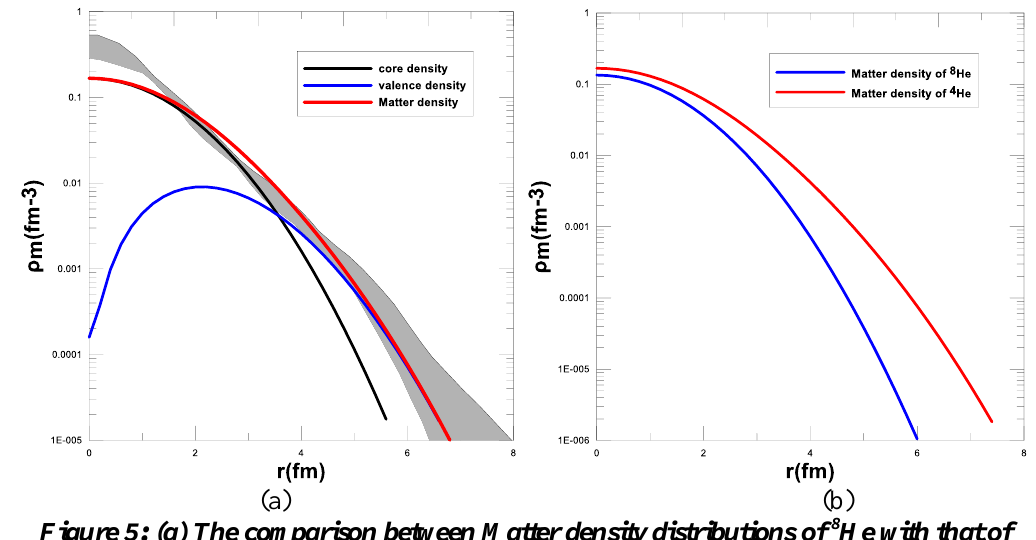
Figure 5: (a) The comparison between Matter density distributions of 8 He with that of experimental data, (b) The comparison between Matter density distributions of 8 He and stable 4 He nuclei.